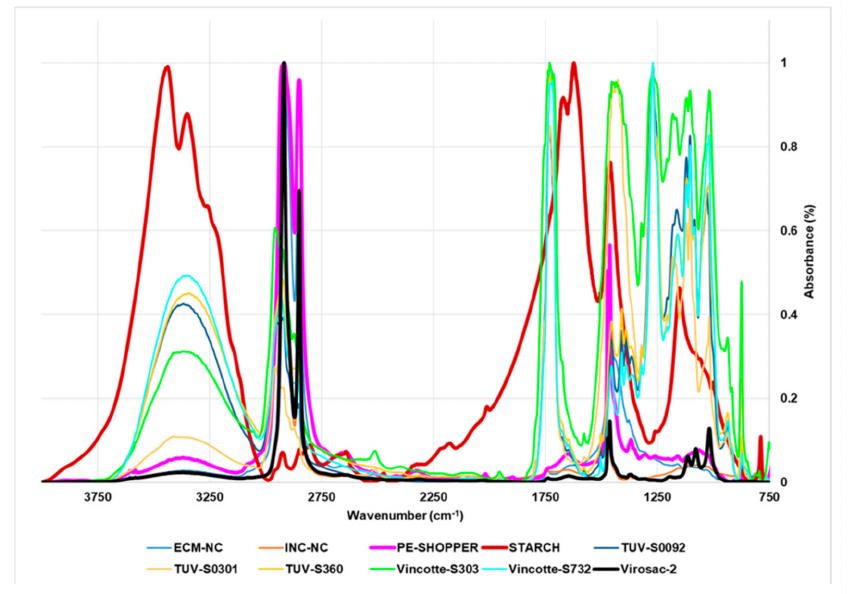
Figure 4. Comparison between the FTIR spectra of 10 significant samples out of the 22 considered in this study. The FTIR spectra of residual samples have not been shown to make it easier to identify differences between samples.